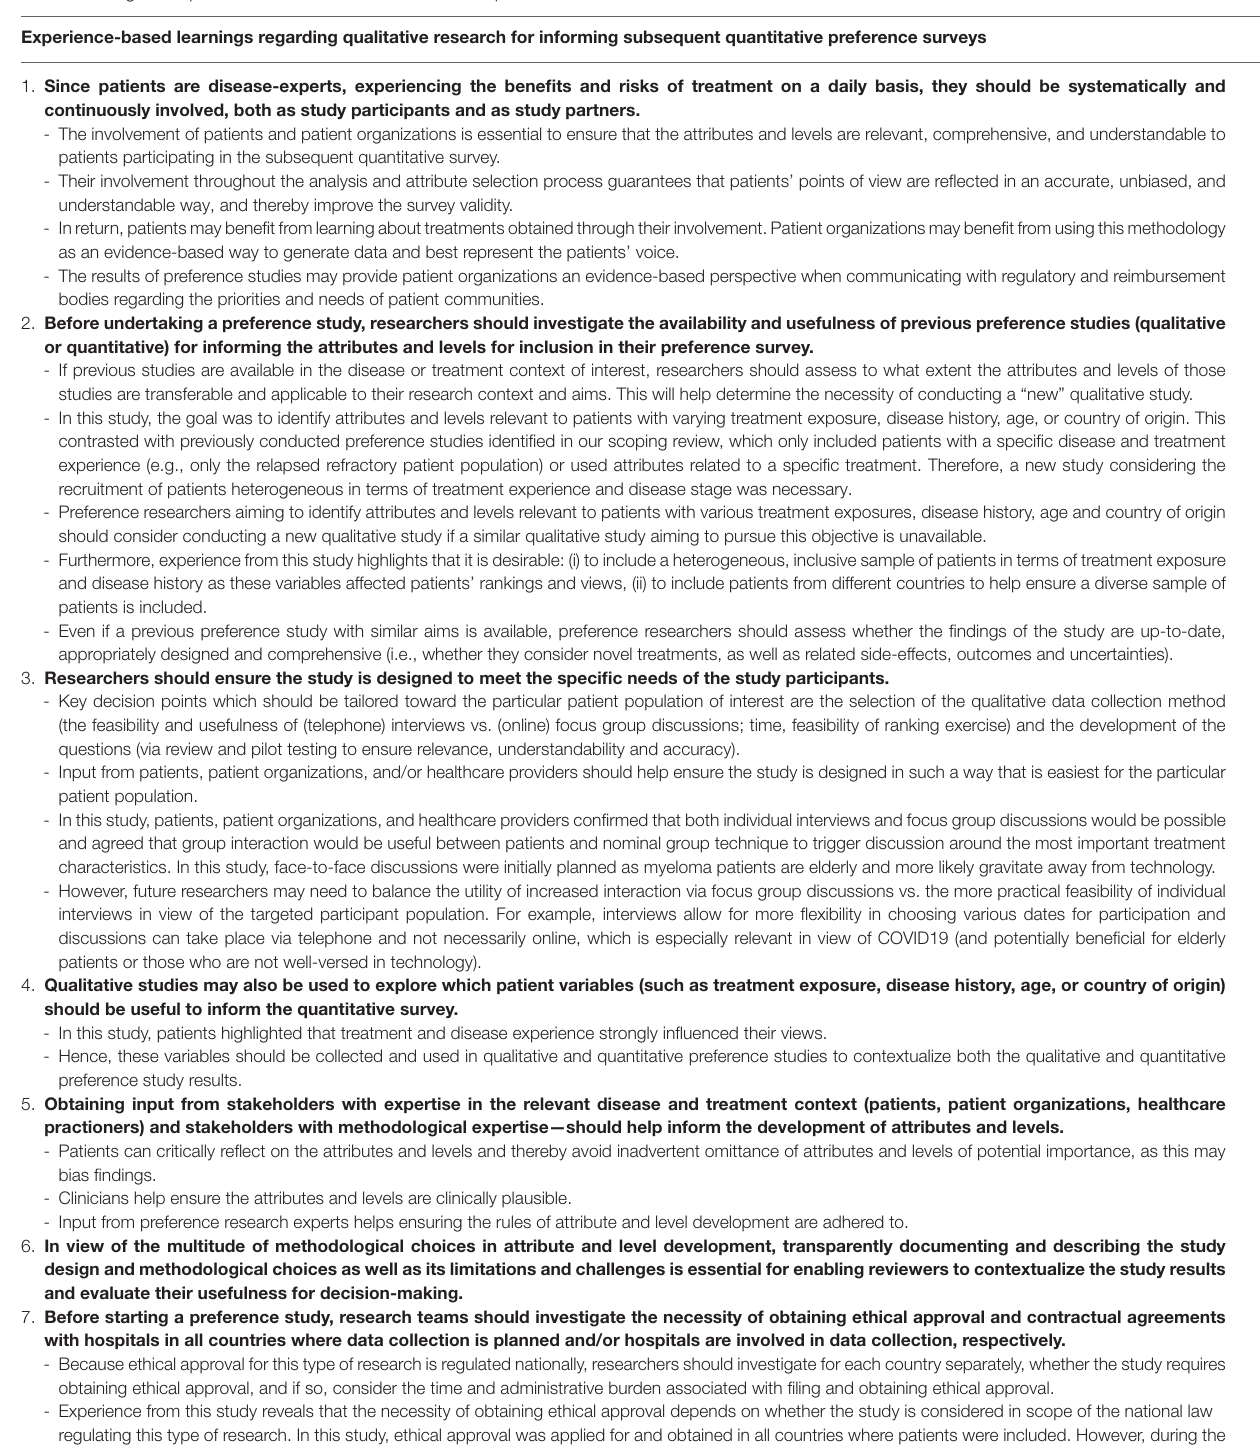
TABLE 2 | Experience-based learnings regarding the design, conduct, and analysis of qualitative research for informing subsequent quantitative preference surveys in the context of drug development and evaluation − 10 avenues for optimization. Experience-based learnings regarding qualitative research for informing subsequent quantitative preference